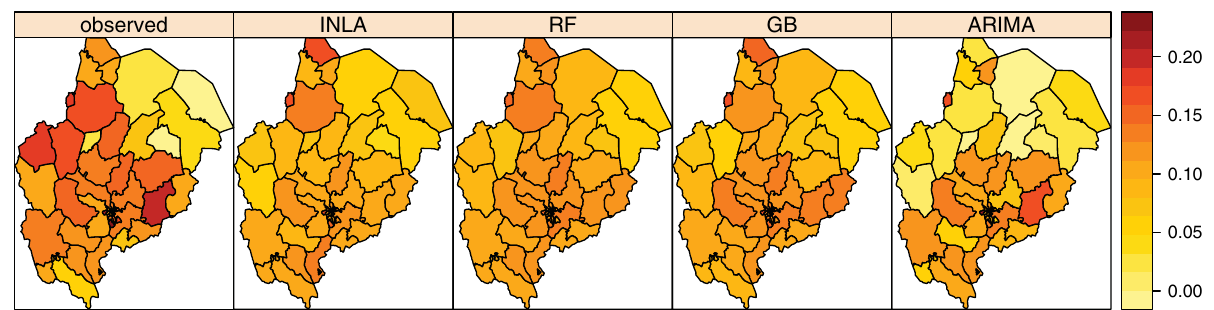
Week 13, 2021 (Uppsala region)